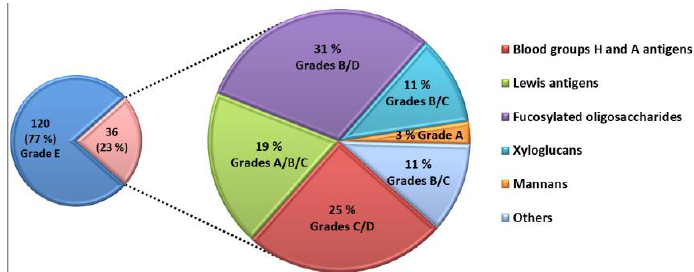
Figure 3. Overview of the screening of the 156 glycans. 36 competed for the interaction of LecB with the immobilized fucocluster F1.